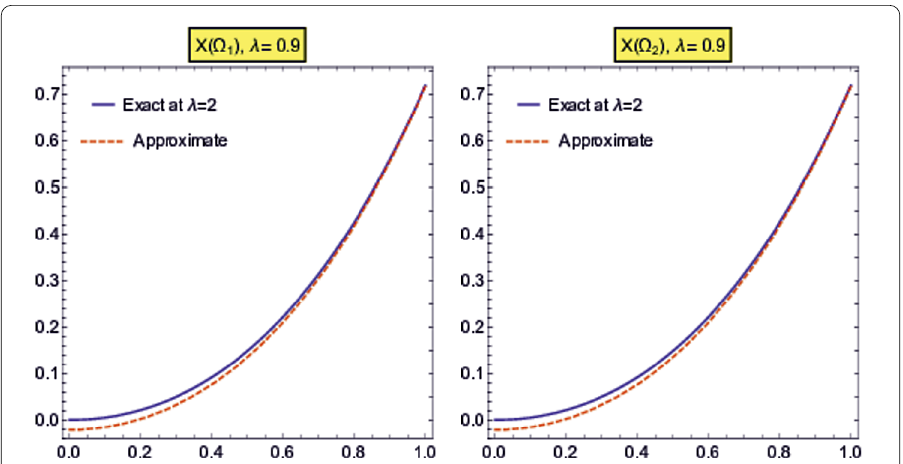
Figure 8 Comparison of the exact and approximate solutions of Example 4.3 for m = 3 and λ = 0.9